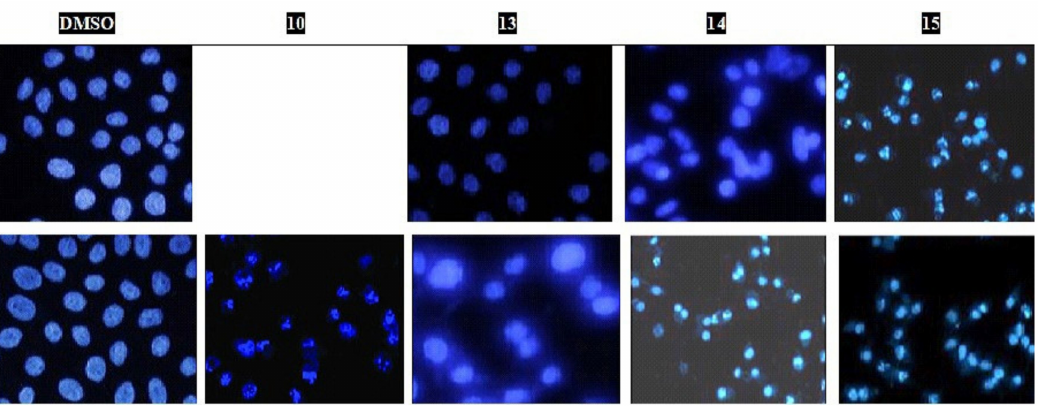
Figure 5. Fluorescent microphotograph section of the treated HepG2 ( A ) and MCF-7 ( B ) cells with DMSO (0.0 µ M) or the IC 50 of the indicated compounds 10 , 13 – 15 for 48 h. Cells were all stained by the Hoechst 33258.